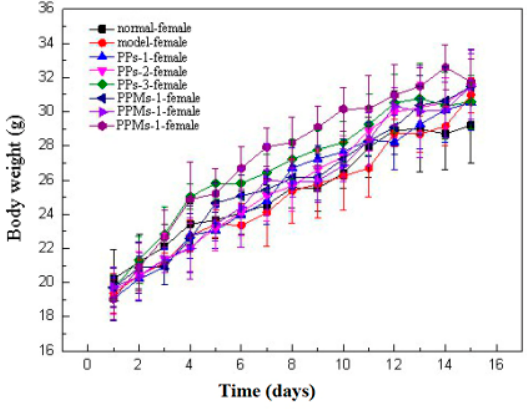
Figure 4. Effect of PP and PPM on the body weight changes of female mice. Molecules 2018 , 23 , x FOR PEER REVIEW